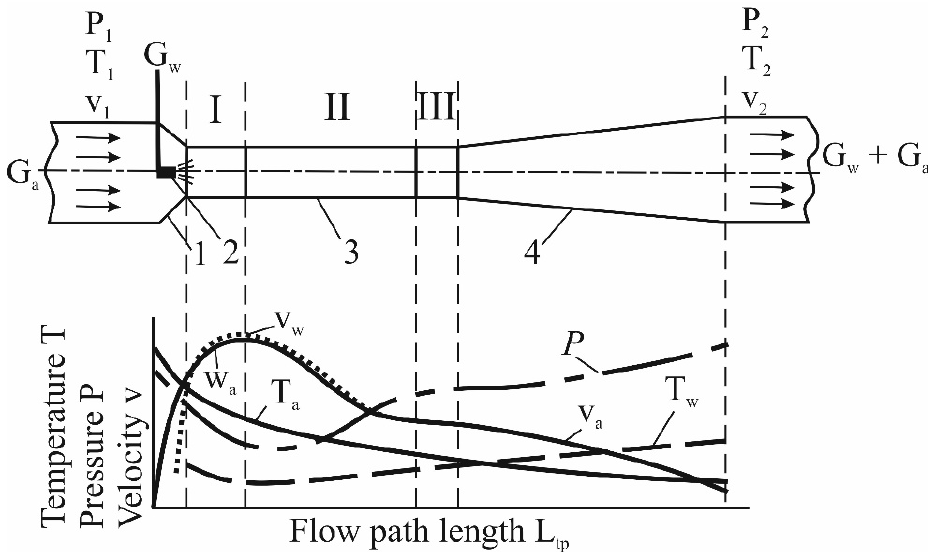
Figure 1. Spatial profiles of the main thermopressor operation parameters: 1—confuser; 2—nozzle; 3—evaporation chamber; 4—diffuser.